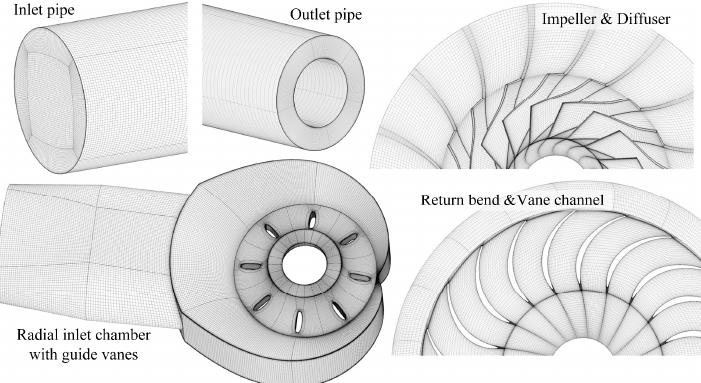
Figure 3. Variations of the flow and performance parameters with the grid number.